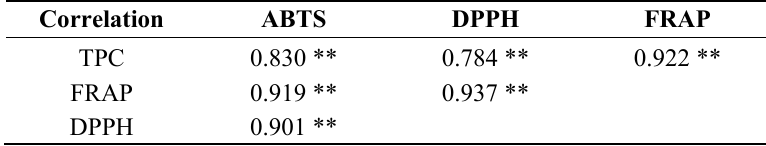
Table 2. Pearson correlation coefficients ( R ) for the total phenolic content (TPC) of aqueous extracts and their total antioxidant capacity measured with the three